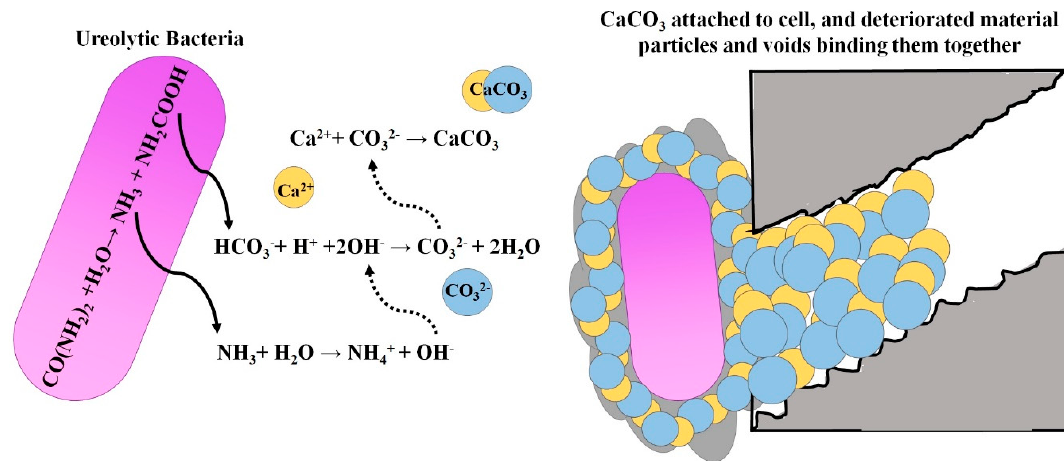
Figure 2. A general overview of chemical processes involved in ureolytic calcium carbonate precipitation.